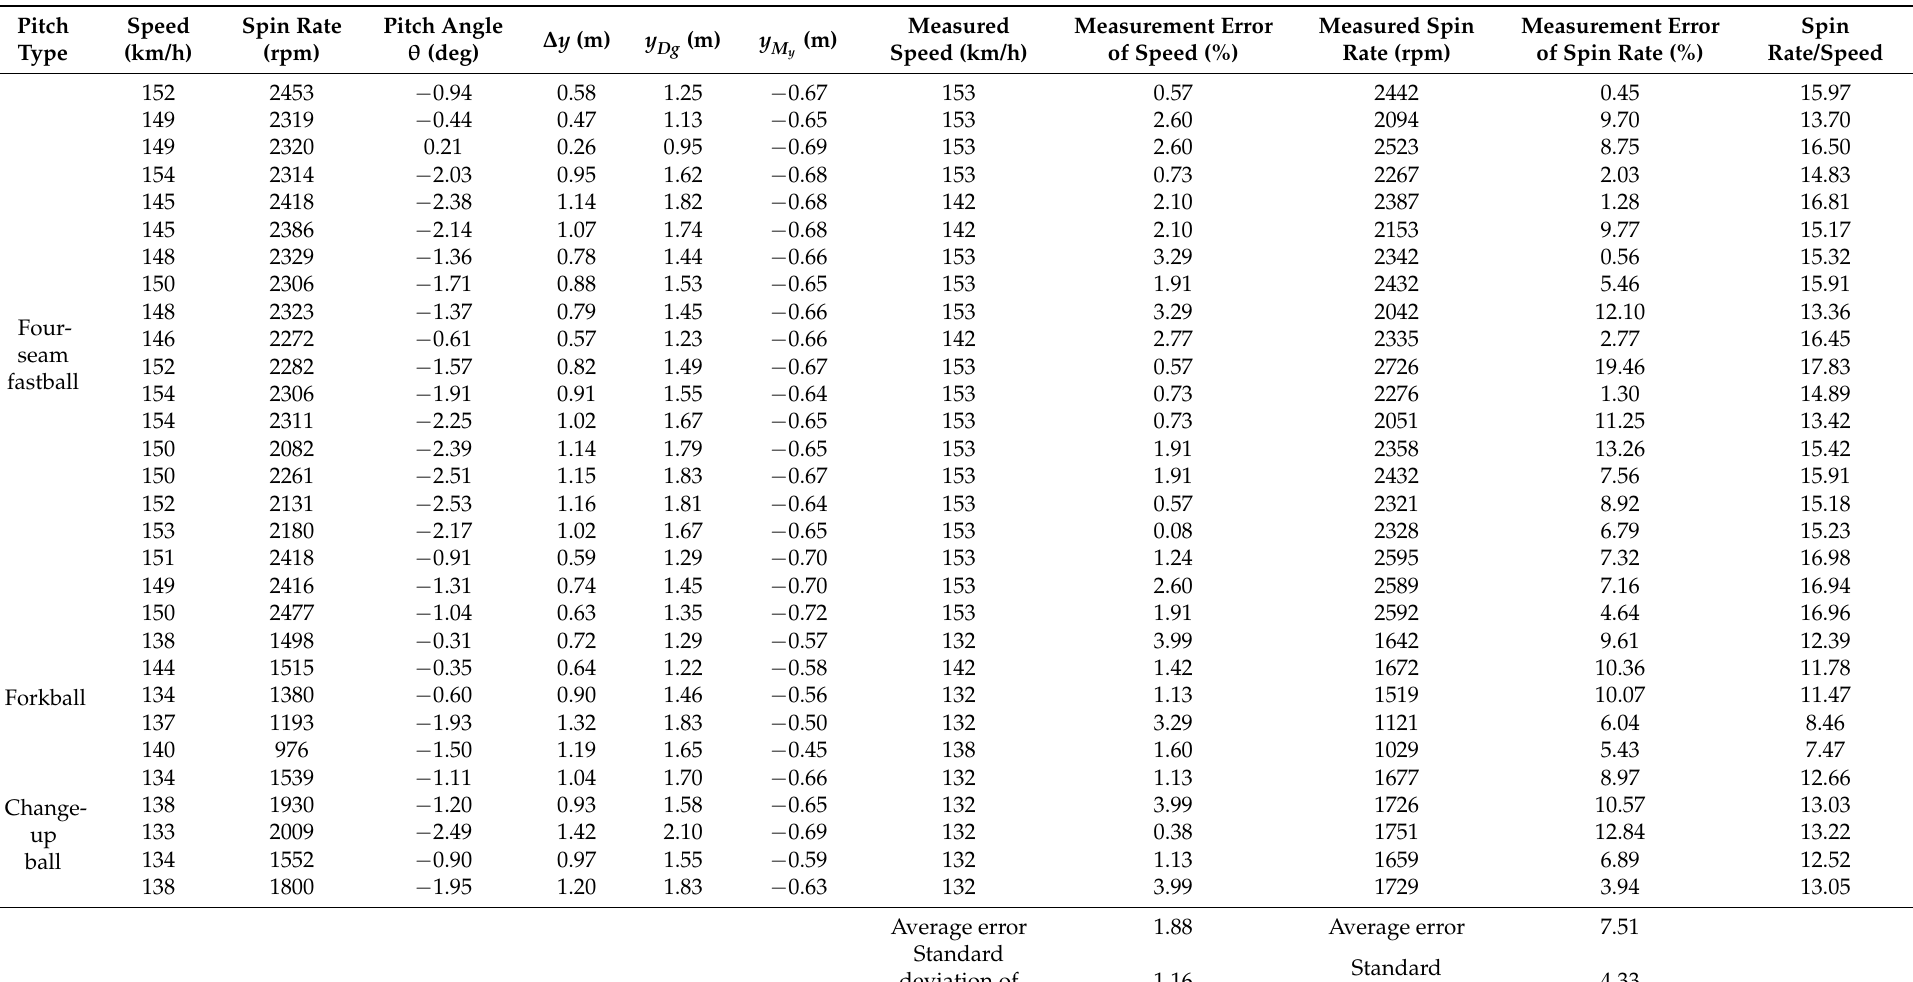
Table 3. Measurement results of the pitched-baseball